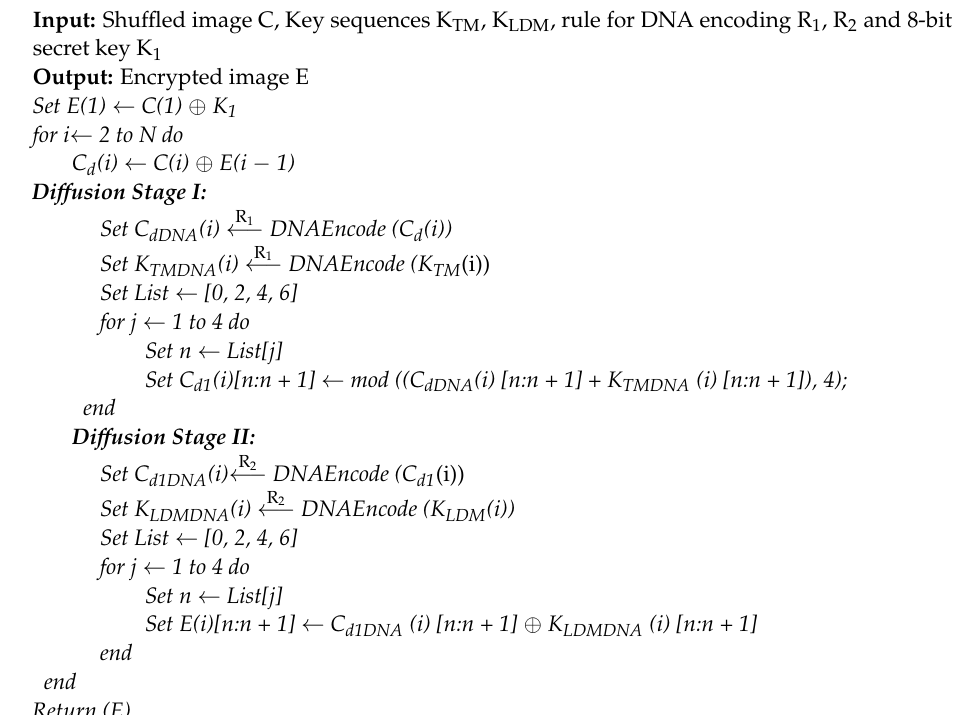
Algorithm 4: Image encryption—cipher block chaining process